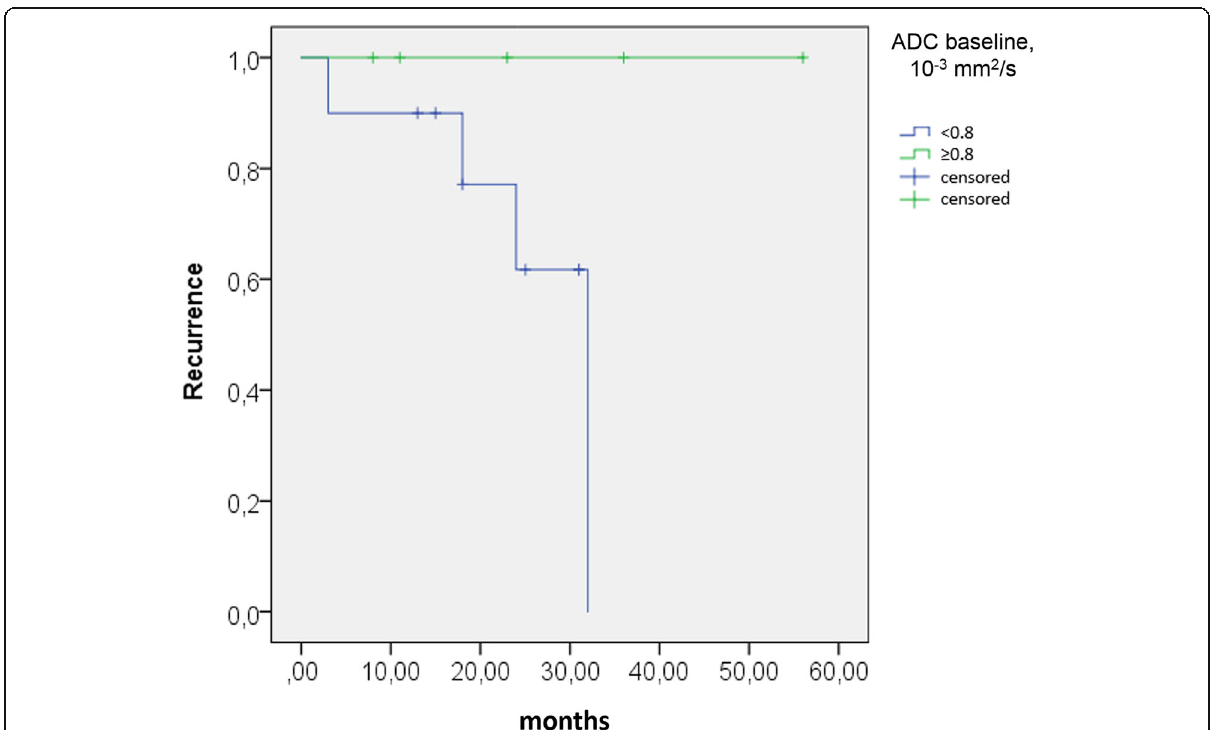
Fig. 7 Kaplan-Meier estimate for neuroblastoma patients ( n = 15) using a cutoff baseline ADC ≥ 0.80 × 10 − 3 mm 2 /s. The initial sample size with an ADC ≥ 0.8 is five patients and with an ADC< 0.80 × 10 − 3 mm 2 /s is ten